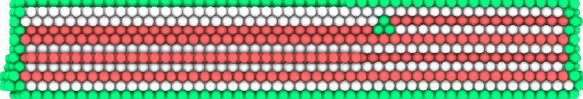
Fig. 5. Cut of the amorphized nanorod by the plane perpendicular to the Y axis. Green shows the surface atoms, white shows the atoms forming the face-centered cubic structure, red shows the atoms forming the FCCP